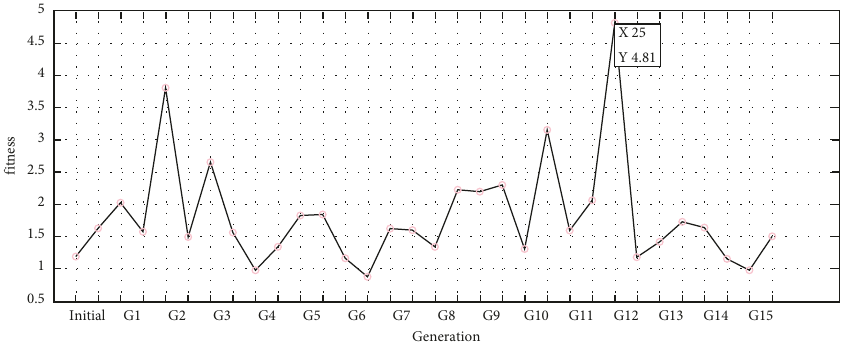
Figure 14: Fitness of